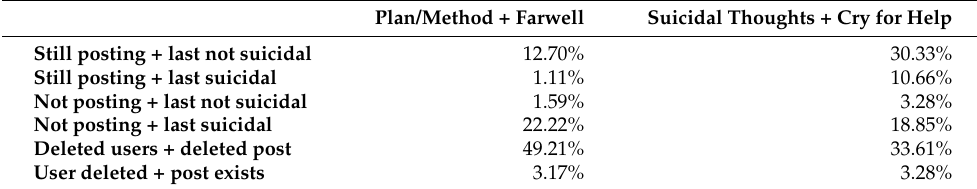
Table 2. Results of the manual verification of user